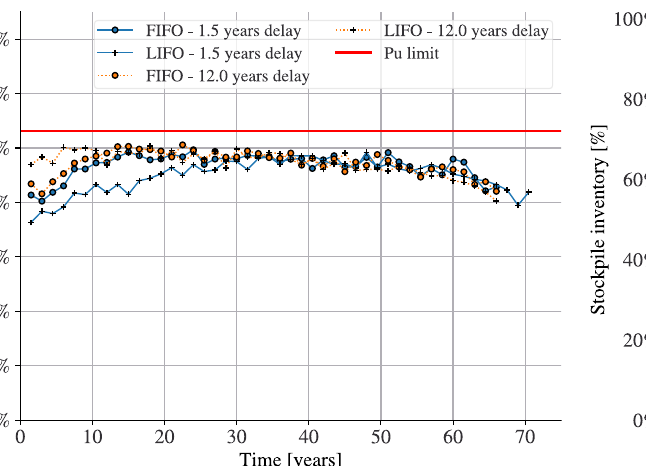
Fig. 9. Fraction of the irradiated UOX assemblies remaining in the stockpile for every reload cycle as a function of time passed since the reference date t 0